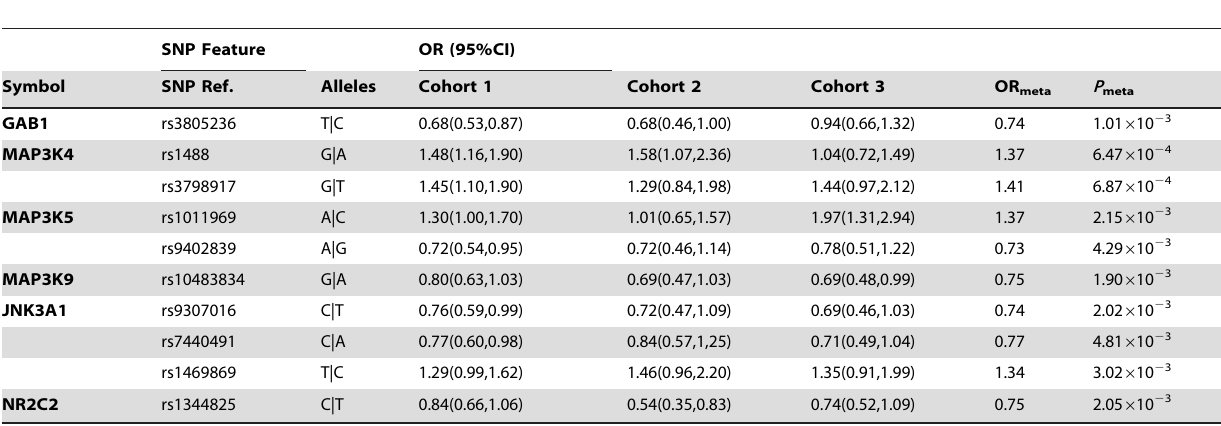
Table 2. AAMD-associated sequence variants ( P # 0.005)* resident in genes of the STKE JNK MAPK pathway.